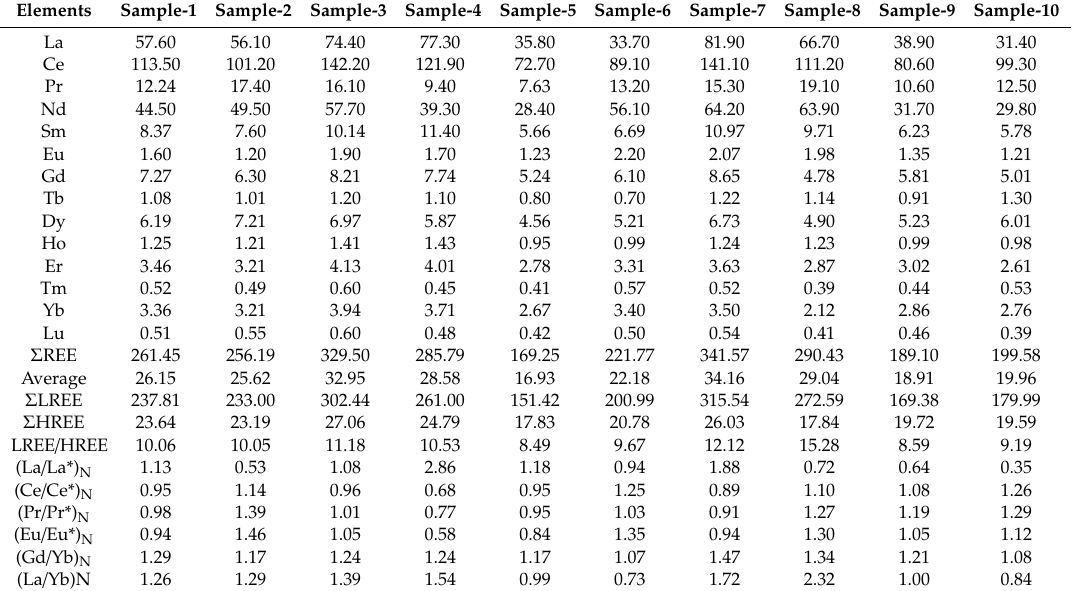
Table 6. Rare earth element (REE) concentrations (ppm) and calculated REE ratios along with di ff erent anomalies of black shale samples from the Semanggol Formation.